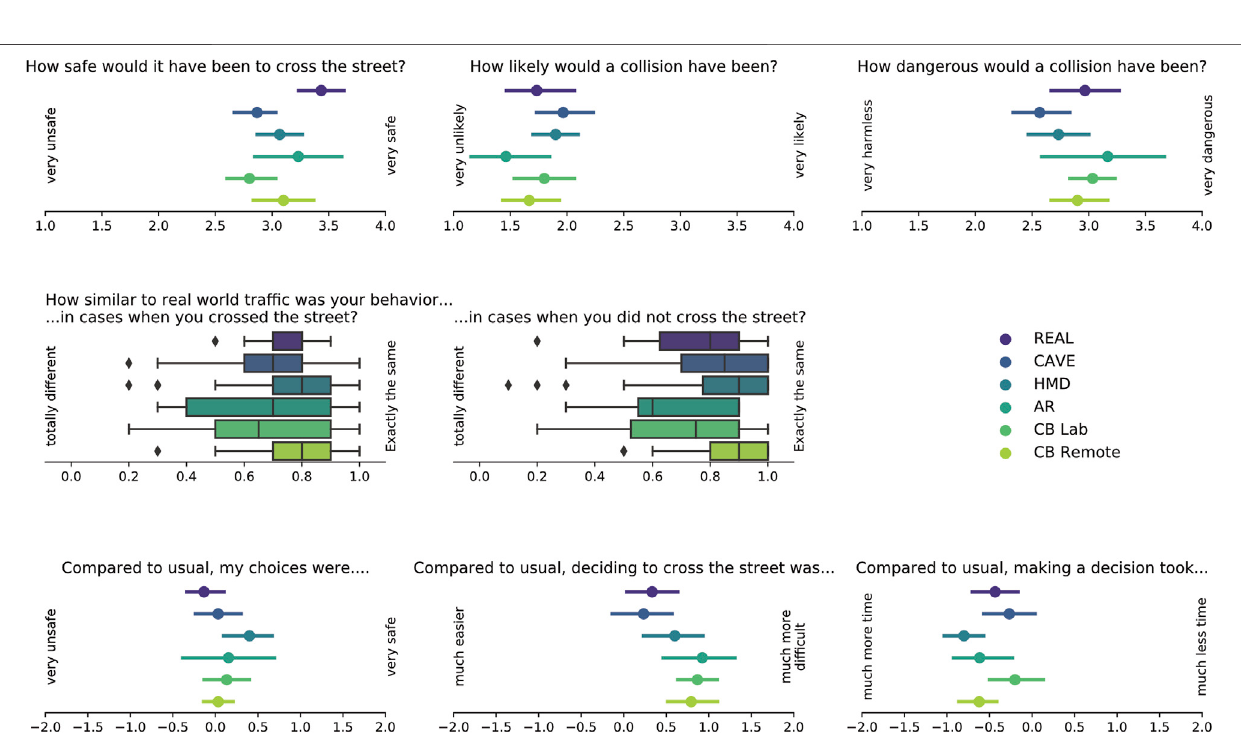
Frontiers in Virtual Reality |